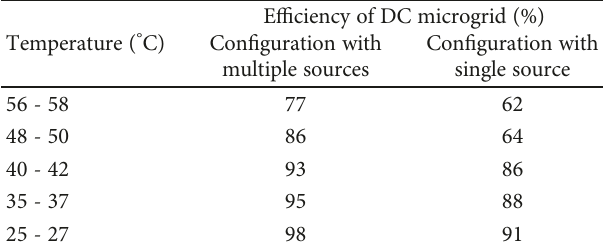
Table 5: System e ffi ciency of the proposed and existing con fi